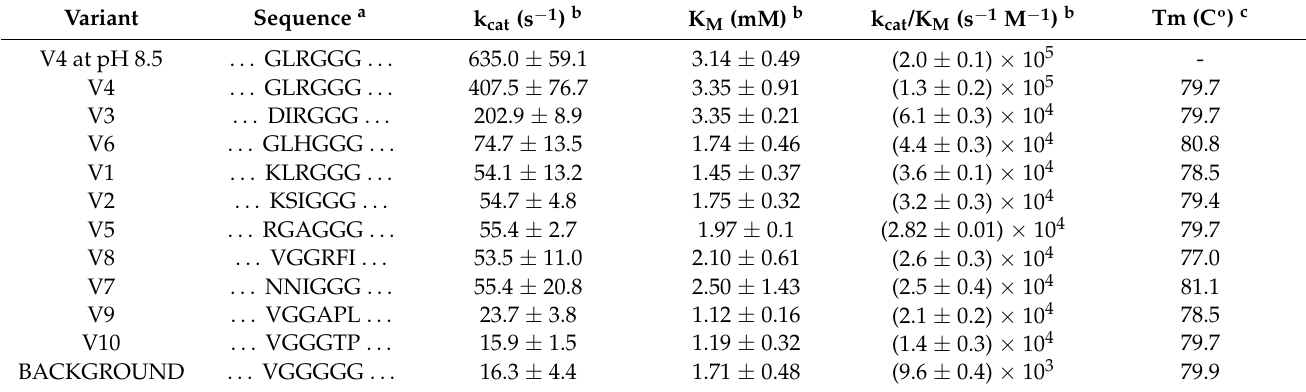
Table 1. Catalytic parameters for the cleavage of 5-nitrobenzisoxazole at pH 7 (HEPES 10 mM NaCl 100 mM) and 1% acetonitrile and 25 ◦ C catalyzed by the engineered and evolved versions of Precambrian β -lactamases. For the best variant, data at pH 8.5 are